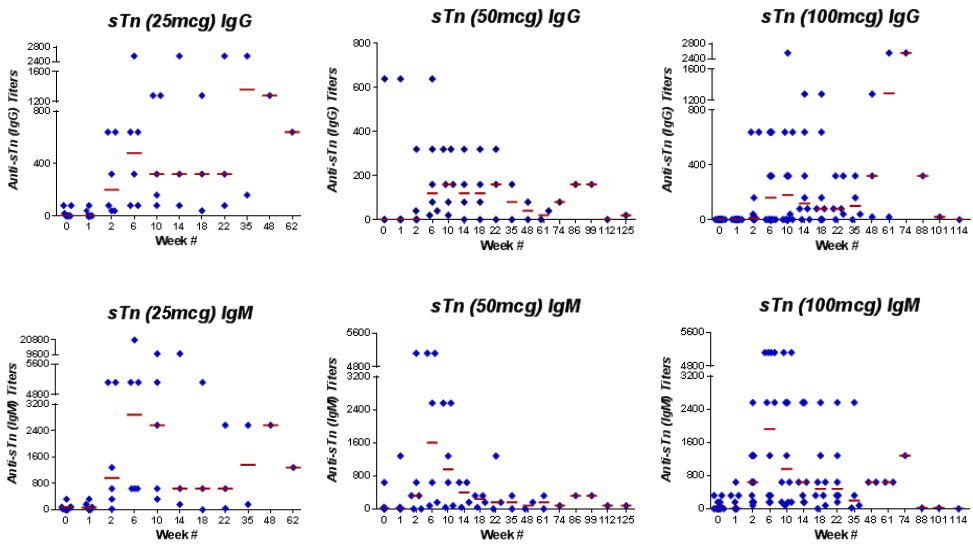
Figure 2. Anti-sTn (IgG and IgM) antibody titers of patients vaccinated with the unimolecular pentavalent-KLH vaccine.